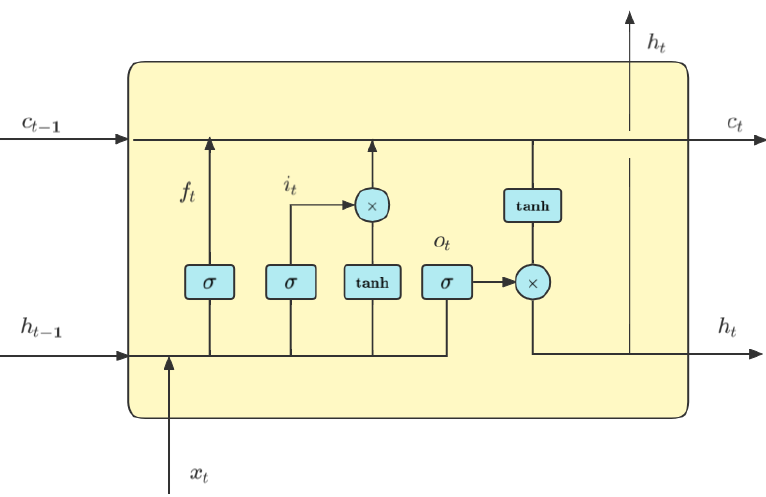
Figure 3. Illustration of a LSTM cell (Redrawn from [36]).